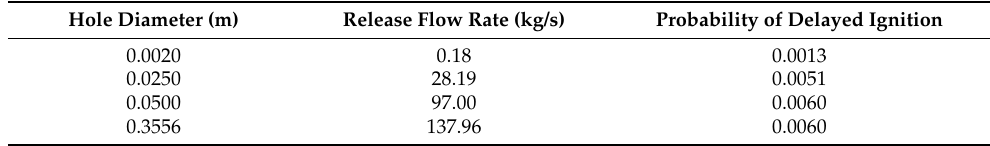
Table 4. Release flow rate (kg/s) and probability of delayed ignition for each failure size